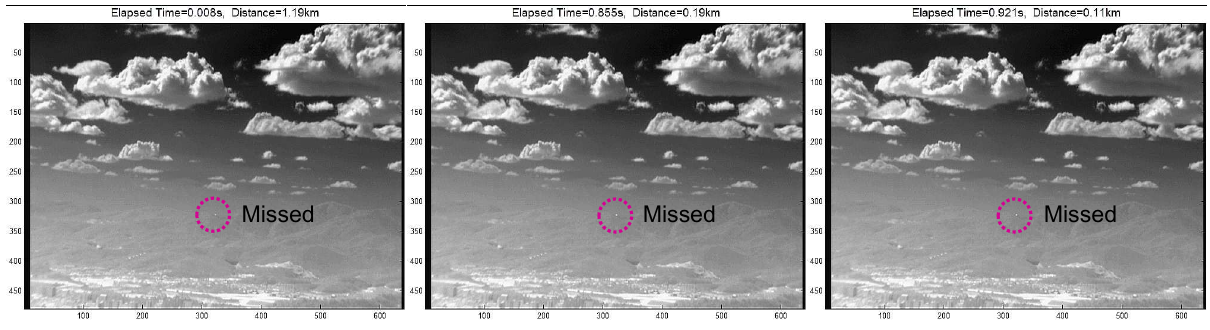
Figure 9. Limitation of the temporal filter (TCF)-based method small target detection